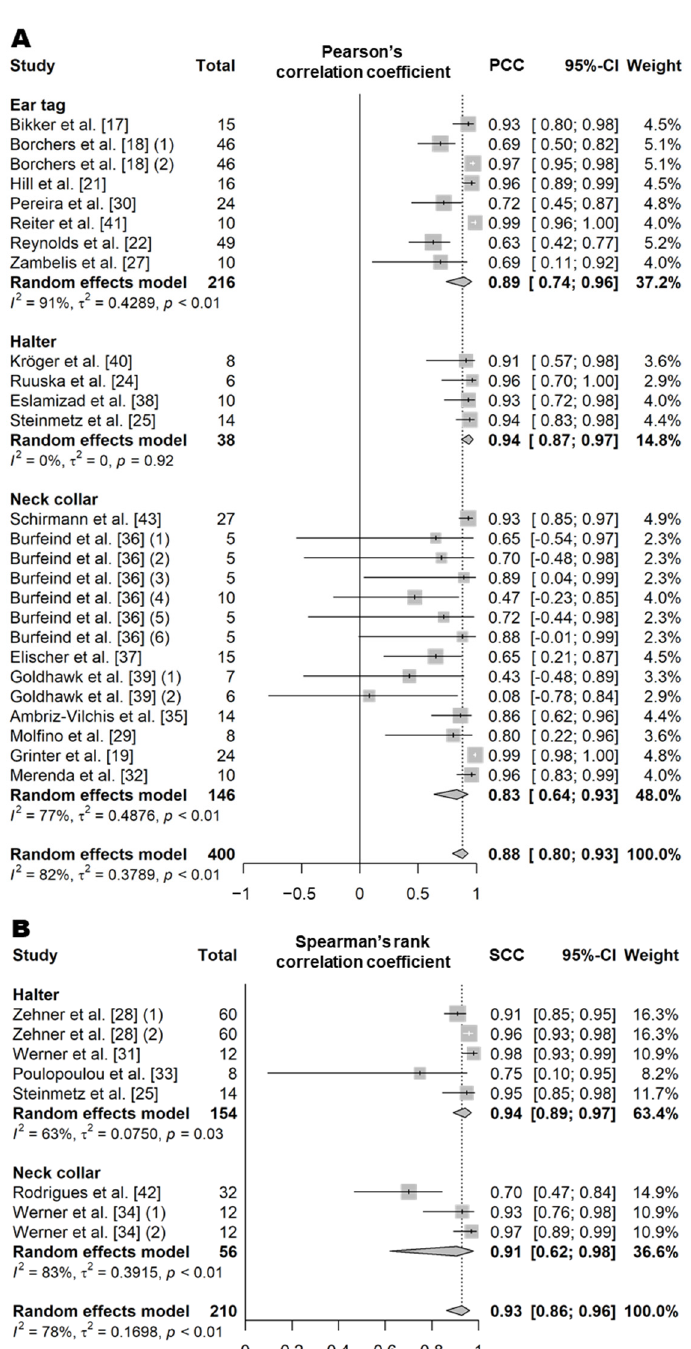
Figure 3. Forest plot of the correlation coefficient of rumination time between wearable sensors and visual observation. ( A , B ) show Pearson’s correlation coefficient and Spearman’s correlation coefficient, respectively. Numbers in parentheses indicate individual studies applying different evaluation conditions within the same article. ‘Total’ means the sample size of each study and ‘Weight’ means the weight for the mean based on the sample size.